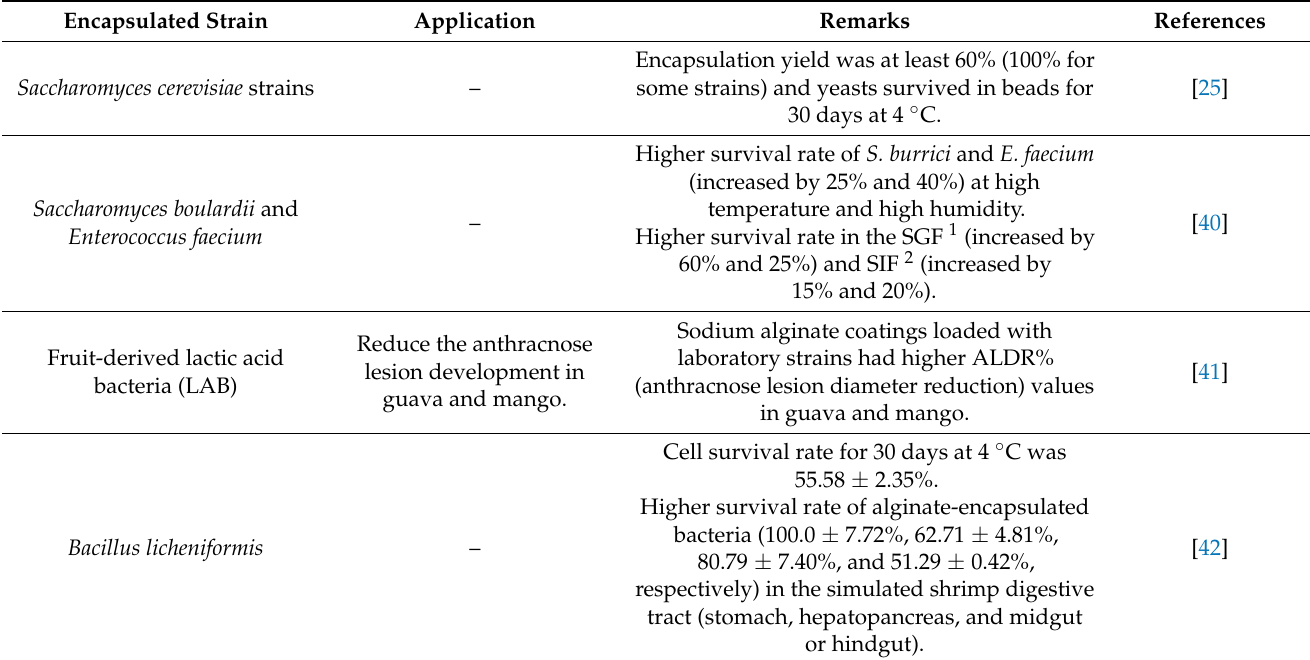
Table 1. Microencapsulation of probiotics with